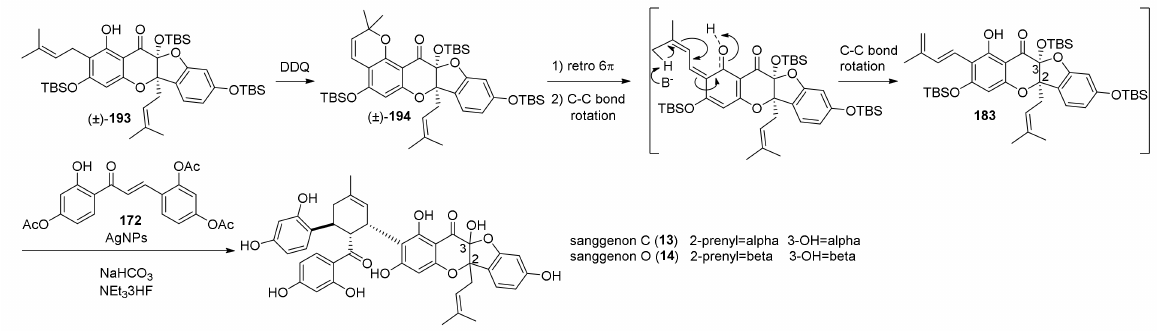
Figure 64. Synthesis of racemic sanggenons C and O ( 13 and 14 ).